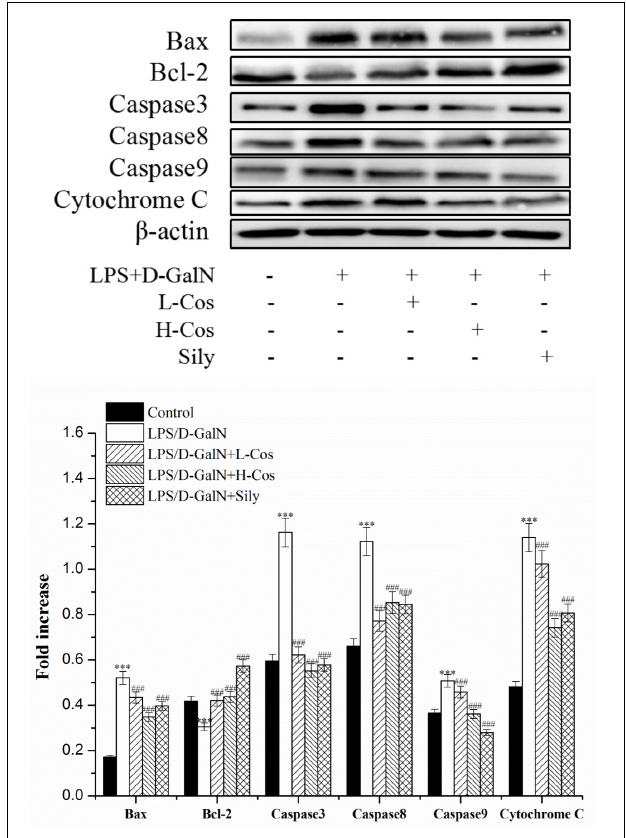
FIGURE 10 | Effects of cos on the expression of apoptosis-related proteins. The expression of hepatocyte apoptosis related proteins Bax, Bcl-2, Caspase3, Caspase8, and Caspase9 were analyzed by western blot. The data represent the mean ± SD ( n = 10). ∗∗∗ P < 0.001 vs. control group; ### P < 0.001 and ## P < 0.01 vs. LPS/ D -GalN